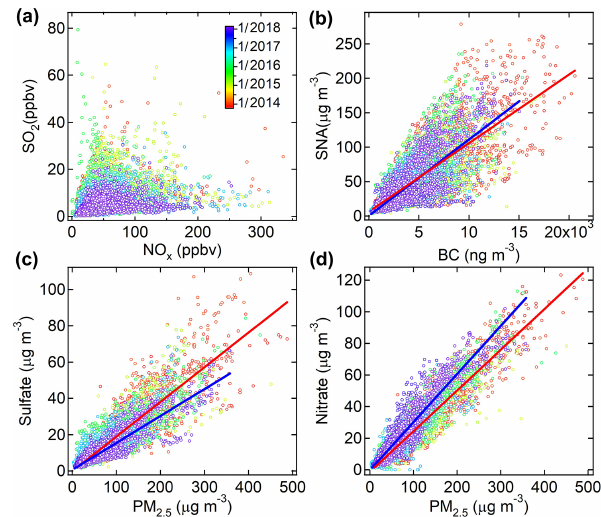
Figure 6. Scatter plots of (a) SO 2 versus NO x , (b) SNA (i.e., the sum of sulfate, nitrate, and ammonium) versus BC, (c) SO 2 − PM 2 . 5 , and (d) NO − versus PM 2 . 5 in November, December, and 3 January during